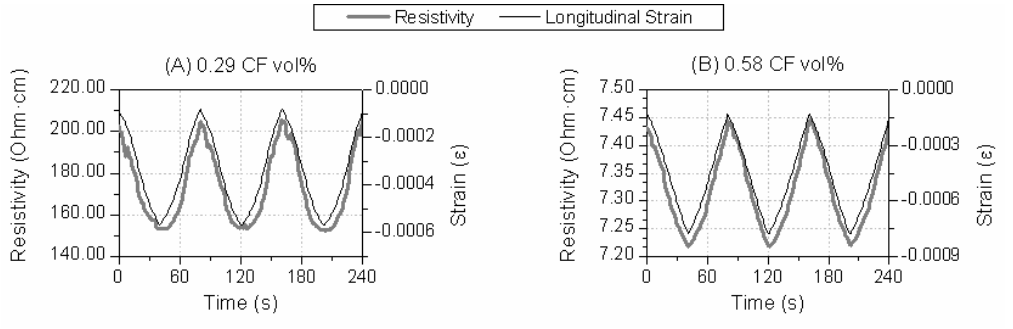
Figure 3. Effect of carbon fiber addition: resistivity and strain versus time for a 5 MPa test and ( A ) 0.29 CF vol %; ( B ) 0.58 CF vol %; ( C ) Fractional change of resistance vs. longitudinal strain for 20 loading-unloading cycles tests, also linear regression functions are